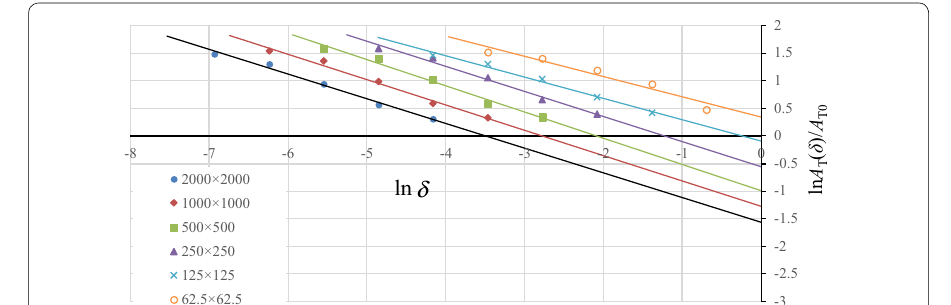
Fig. 11 Comparison diagram of fractal dimension fitting in different size